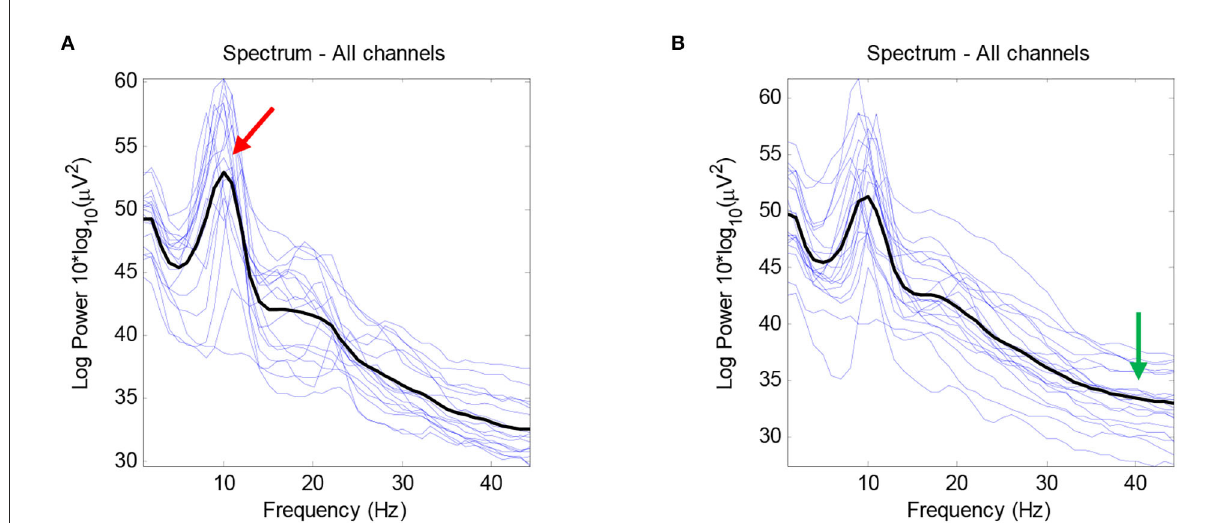
FIGURE4 The average power spectrum plot after removing the artifacts for the healthy group (A) and the RRMS group (B) in black color using EEGLAB. The power spectrum plots for individual subjects are demonstrated in blue color. The peak in the alpha frequency band is higher in healthy subjects (red arrow), and the average gamma power is higher in patients with RRMS (green arrow). In this figure, the x-axis indicates the frequency, and the y-axis indicates the average power ( Log Power 10*log 10 ( µ v 2 )).